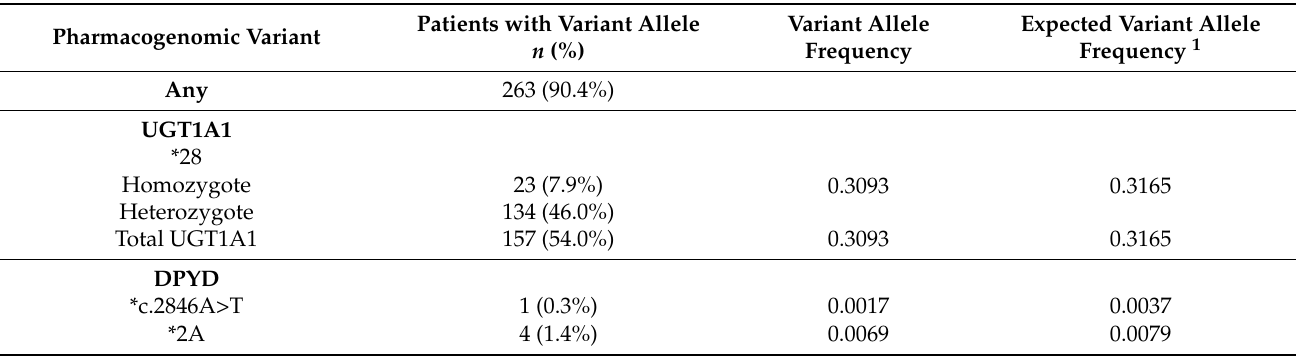
Table 2. Pharmacogenomic variants and patient frequencies. The number of patients and percentage refers to heterozygotes unless otherwise